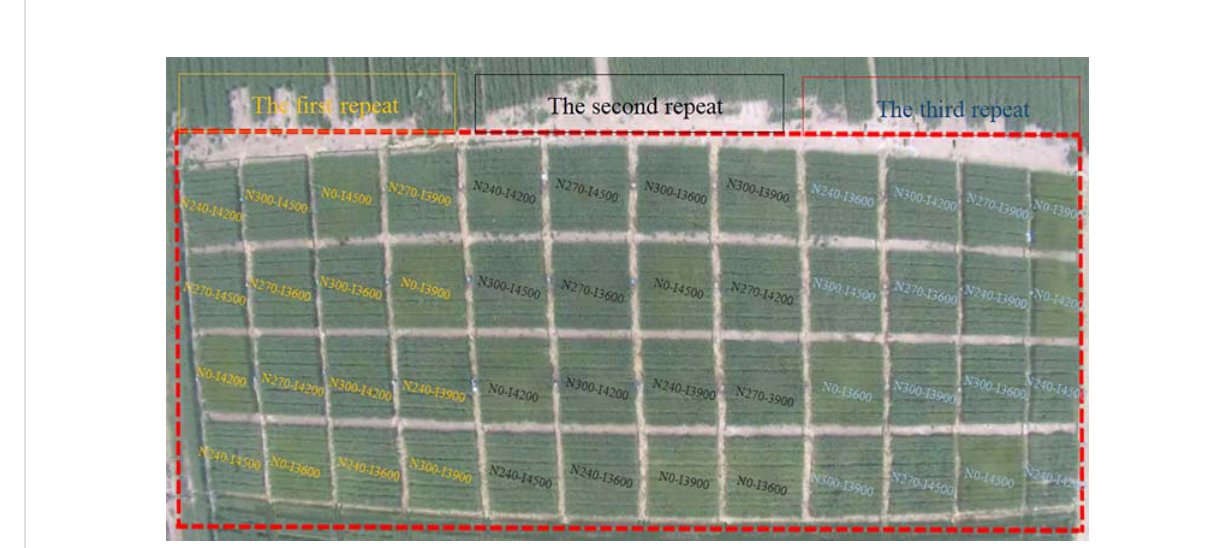
FIGURE 1 The experimental plot layout (16 treatments, three replicates, a total of 48 experimental plots). Notes: I4500, I4200, I3900, and I3600 indicate 4500, 4200, 3900, and 3600 m 3 ha − 1 irrigation levels, respectively. N300, N270, N240, and N0 indicate 300, 270, 240, and 0 kg ha − 1 nitrogen levels,